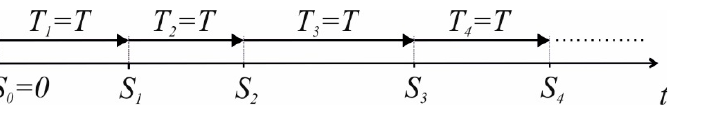
Figure 2. Assuming that the FBM restores the system to an as-good-as-new state, it holds that all renewal cycles are equivalent; i.e., T i = T j = T for all i , j ∈